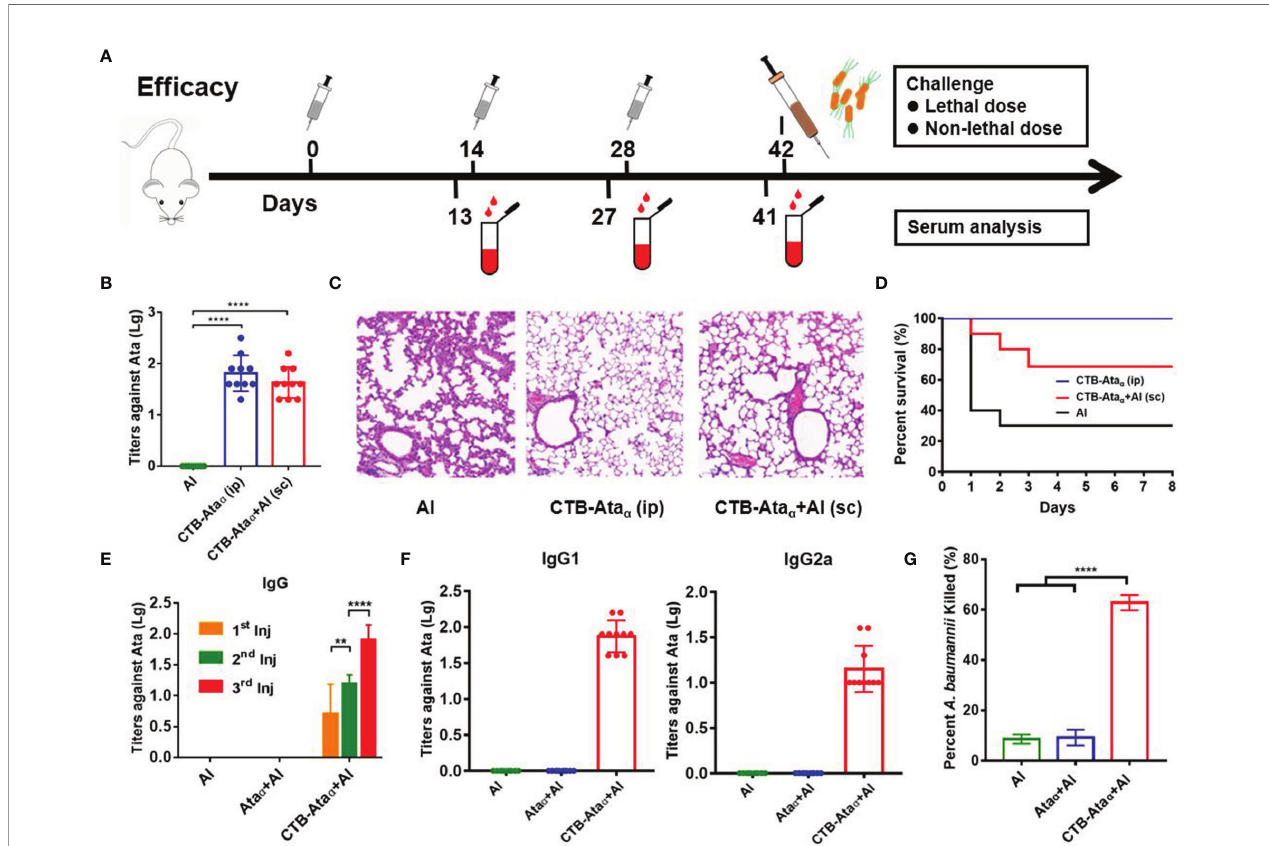
FIGURE 3 | Immune response of CTB-Ata a . (A) Immunization and ef fi cacy evaluation schedule. (B) Comparison of Ata a -speci fi c IgG titers between different injection strategies. (C) HE staining analysis of lung tissue after infection of immunized mice 12 h post-challenge with a non-lethal dose. (D) Survival rates of differently immunized mice. (E) Ata a -speci fi c IgG levels were measured in the serum of BALB/c mice immunized with Ata a +Al and CTB-Ata a +Al after immunization. (F) Ata a - speci fi c IgG subtypes (IgG1 and IgG2a) were detected after the third boost. (G) Opsonophagocytic assay. Mouse serum complement, HL60 cells, and ( A ) baumannii ATCC 17978 were incubated in round-bottom 96-well plates with shaking and plated in LB medium to measure bacterial survival by counting colony-forming units, and the percentage of killing was calculated. Data are presented as means ± s.d. Each group was compared using one-way ANOVA with Dunnett ’ s multiple- comparison test. **** P < 0.0001, ** P <